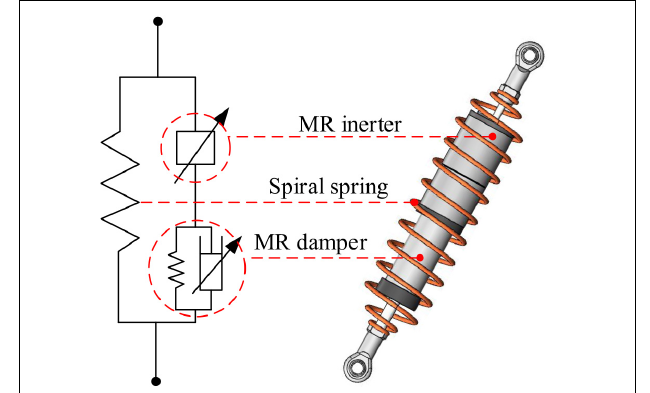
FIGURE 1 | Schematic of the integrated